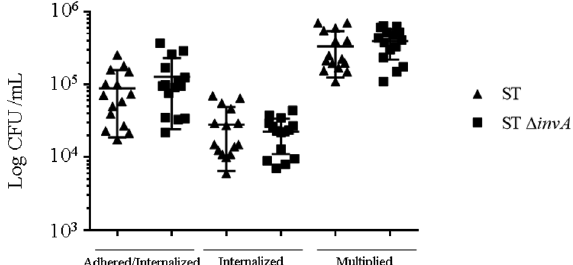
Figure 1. S. Typhimurium 14028 inactivated for T3SS1 activity by invA mutation remained as invasive as the wild-type strain in the AML12 cell model. In repeated gentamicin protection assays, adhered, internalized and multiplied ST (black triangles) or ST Δ invA (black squares) were monitored on AML12 cells. Cells were exposed to each strain (MOI = 50) for 60 min (adhesion/invasion) followed by the addition of gentamicin (100 μg/mL) for 60 min (Invasion), followed by a further 15 h with gentamicin (10 µg/mL) (multiplication). The results correspond to the mean ± standard deviation of at least four independent experiments